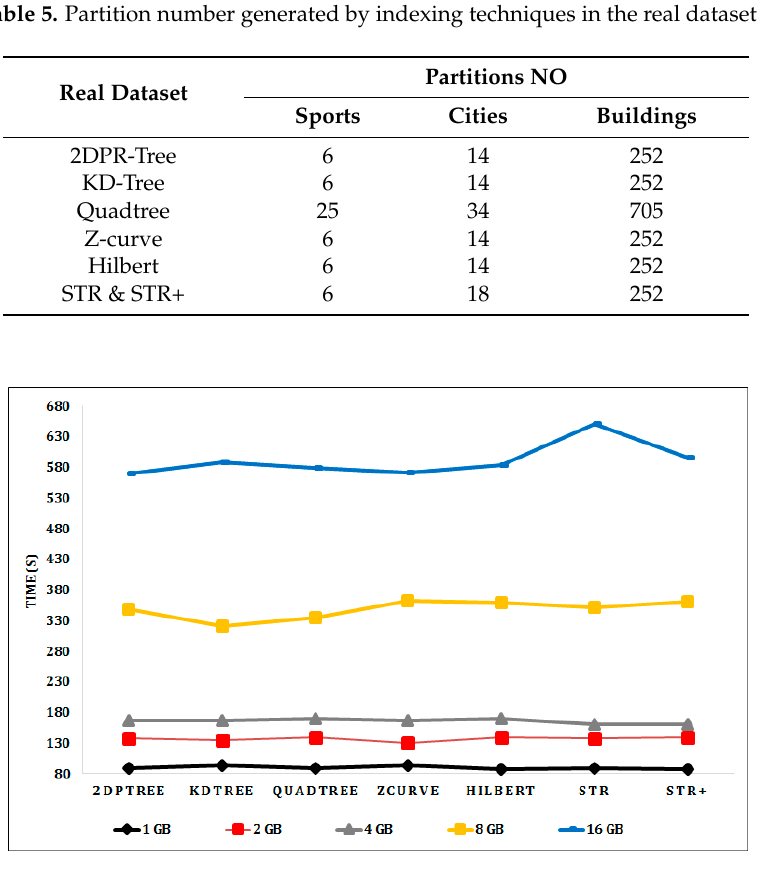
Figure 6. Indexing time for the real datasets (Sports, Cities, and Buildings). The range and kNN queries, as presented in the paper by Ahmed Eldawy and Mohamed Mokbel [12], were performed on the partitioned data to quantify and examine the performance of the diverse partitioning strategies. For the range query, the rectangular area A is revolved over arbitrary records from the input dataset. The measure of A is balanced with the end goal that the query area is equal to the selection ratio ( σ ) multiplied by the total area of the working file, as shown in Equation (1): (cid:1827) = (cid:2026) ∗ (cid:1827)(cid:1870)(cid:1857)(cid:1853)((cid:1835)(cid:1866)(cid:1839)(cid:1828)(cid:1844)) ,